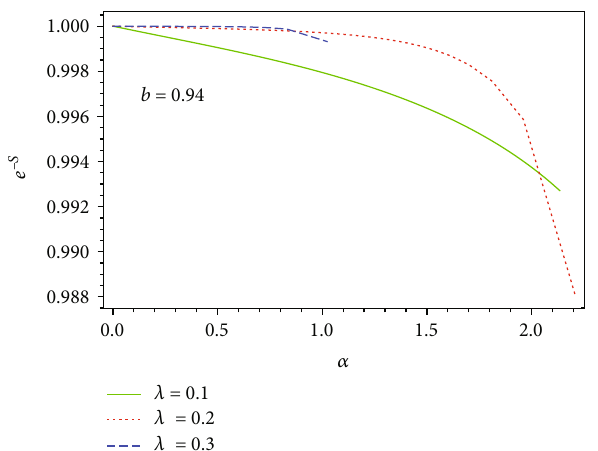
Figure 11: Considering pair production rate at fi nite temperature and fi xed probe brane position and di ff erent large values of scale parameter.